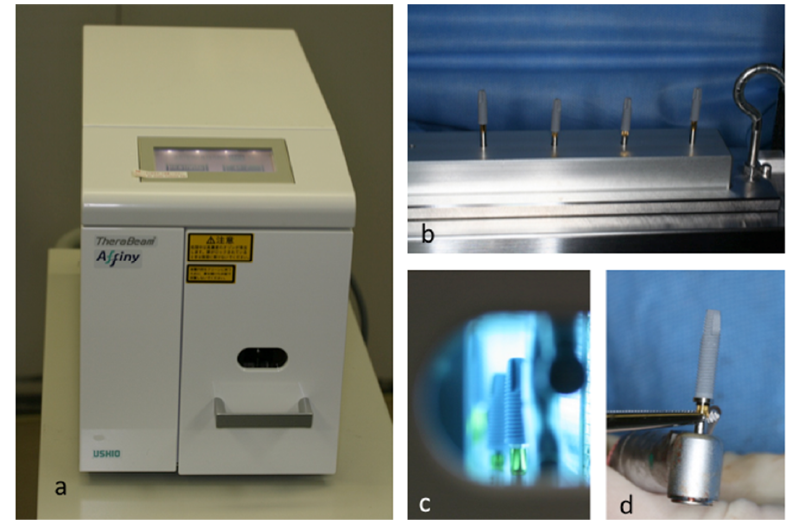
Figure 1. Device for photofunctionalization on dental implants: ( a ) TheraBeam ® Affiny and ( b ) implant stand. Six implants can be set. ( c ) Dental implant is treated with Ultraviolet light, ( d ) How to set a photofunctionalized implant into a handpiece.